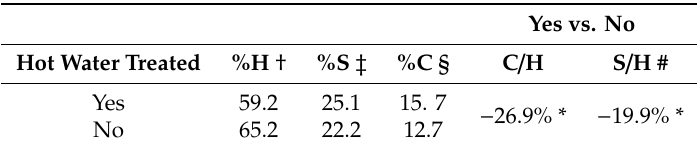
Table 6. Percent hybrid (H), selfs (S), and o ff -type (C) and the percent di ff erence from the odds ratio of o ff -type to hybrid and selfs to hybrid for hot water treated flowers.